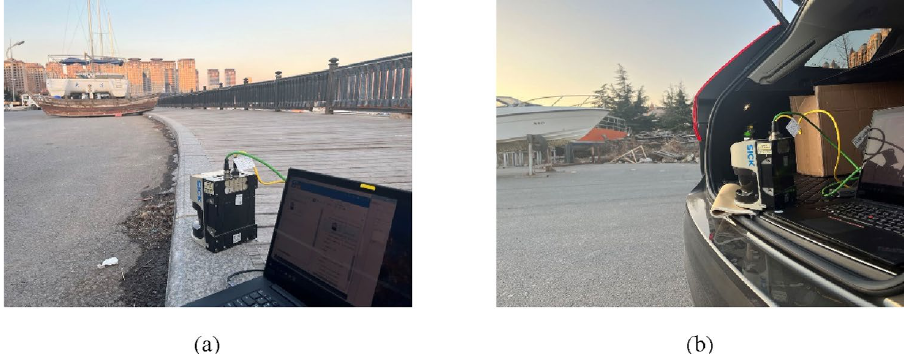
Figure 7. The data sampling of fishing vessel by SICK laser scanner, ( a ) wooden fishing vessels, ( b ) PE plastic fishing